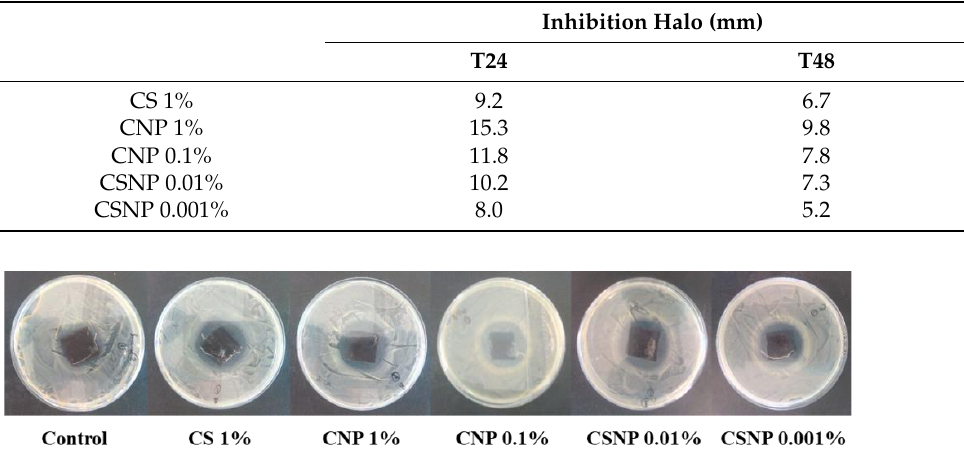
Figure 5. Halo tests in leather samples from the dyeing phase (D) against S. aureus. Table 2. Inhibition halo (mm) of leather samples obtained from dyeing industrial process D after treatment with CS 1%, CNP 1% or 0.1%, CSNP 0.01% or 0.001%, against S. aureus. The measurement of the halo presented is obtained by subtracting the control’s halo to the measure of the sample’s halo under